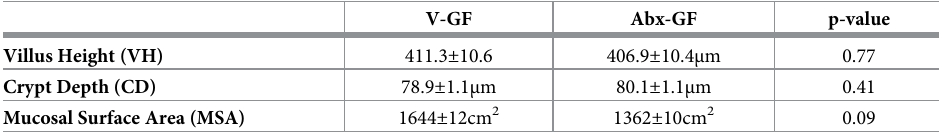
Table 1. Morphometric parameters in germ-free mice (Mean ±